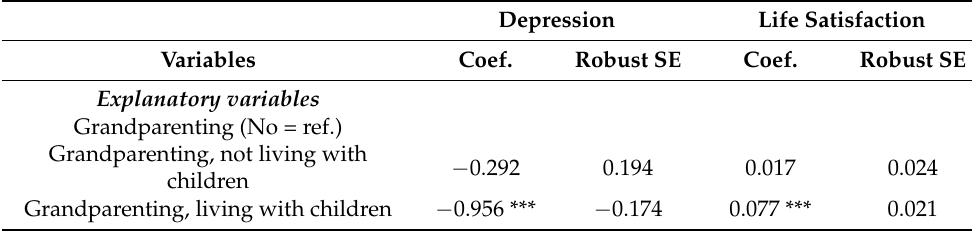
Table 2. Multilevel regression of grandparenting on depression and life satisfaction among Chinese